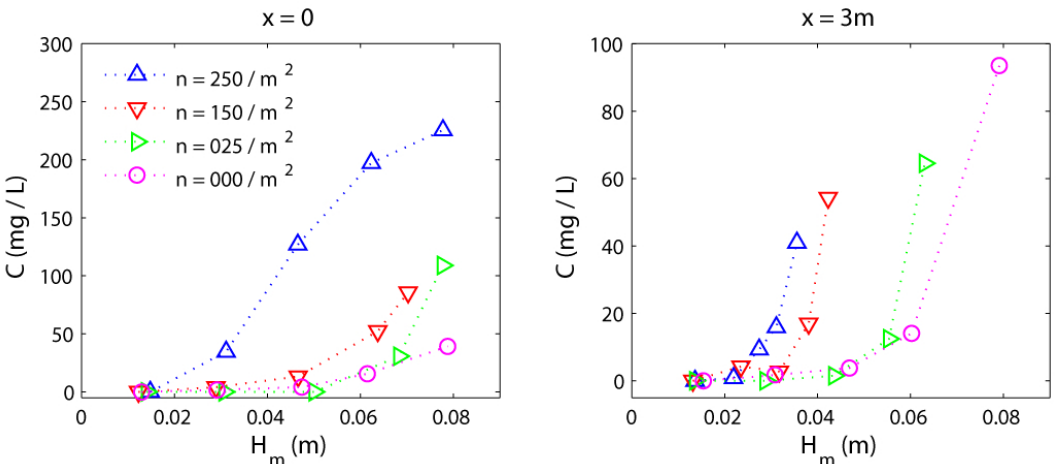
Figure 11. Mean concentrations against measured mean wave heights for all densities at two instrumented locations. Notice the di ff erent vertical scales.